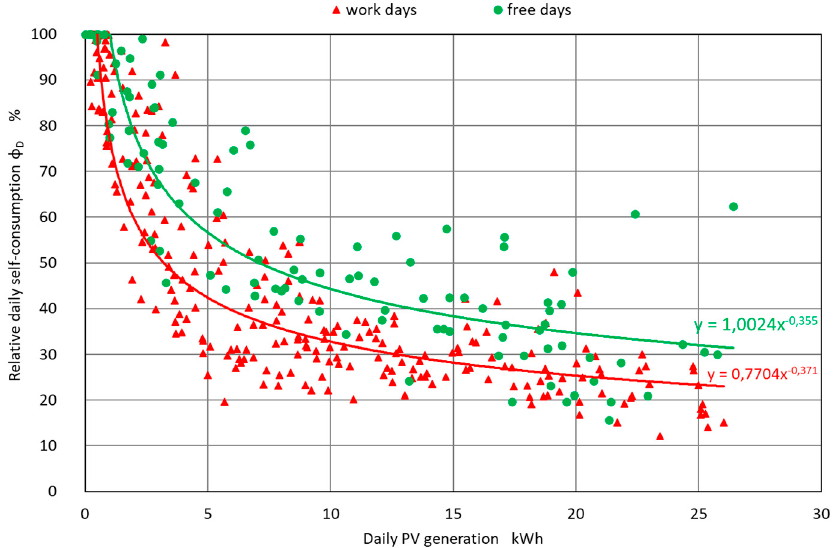
Figure 14. Relative self-consumption as a function of daily generation with PV divided into work and free days.